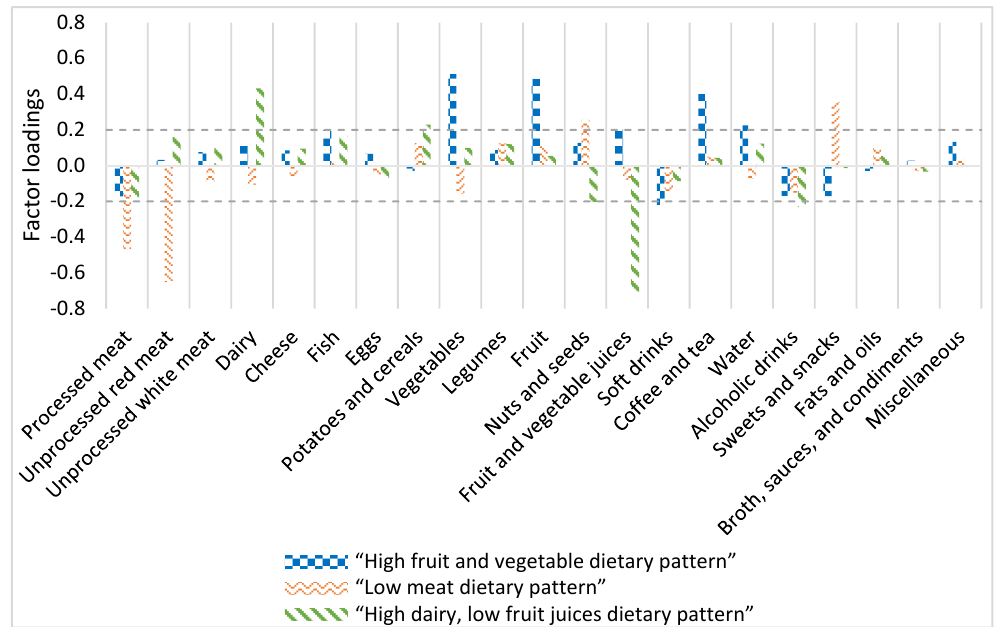
Figure 1. Factor loadings of the food groups on three dietary patterns derived by reduced rank regression explaining the variation in the Dutch Healthy Diet 2015 index scores, dietary greenhouse gas emission, and dietary blue water use. Factor loadings >|0.20| were considered important contributors to a dietary pattern. Note: of the “low meat dietary pattern”, pattern scores of participants and factor loadings were multiplied by ( − 1) to obtain the healthier and more sustainable diet in quartile